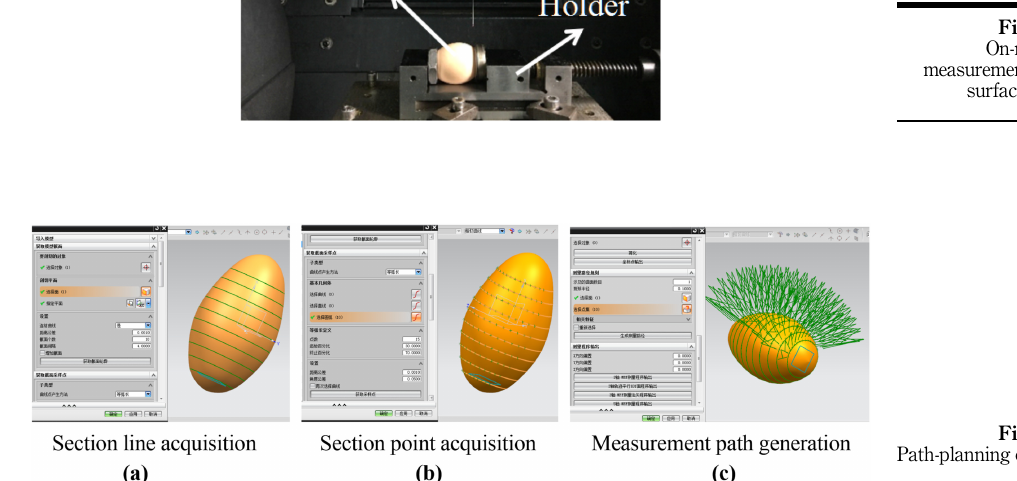
Figure 3. Path-planning of